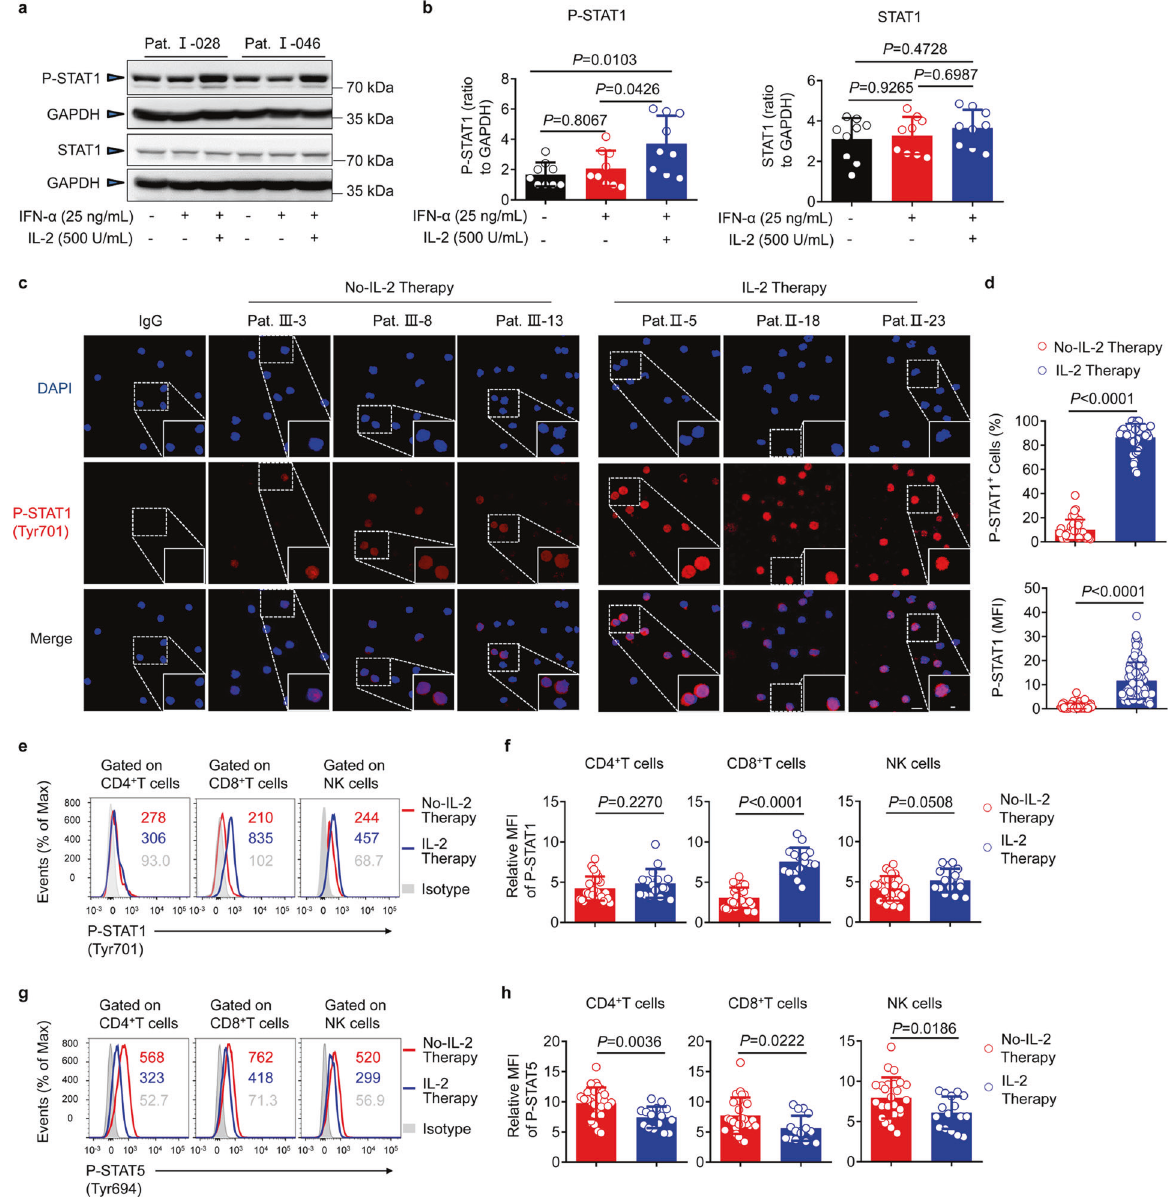
Fig. 4 Increased P-STAT1 and decreased P-STAT5 expression after sequential IL-2 therapy in vivo. a Western blotting analysis of P-STAT1 and STAT1 levels in PBMCs of NR ( α -2b) patient at week 72 (72 w; 48 weeks of Peg-IFN- α -2b therapy and 24 weeks of follow-up). PBMCs were stimulated with IFN- α (25 ng/mL) or co-stimulated with IL-2 (500 U/mL) for 30 min ex vivo. b Graphs on the right show the densitometric evaluation of a , con fi rming their signi fi cance; n = 9. c Confocal microscopy of P-STAT1 expression in the PBMCs of patients, with or without sequential IL-2 therapy for 24 weeks. d (Upper) Statistics were based on the percentage of P-STAT1 + PBMCs per fi eld of each group; each dot represents the percentage of P-STAT1 + PBMCs in one fi eld. The total number of fi elds counted in each group without (No-IL-2) and with sequential IL-2 therapy was 36 and 37, respectively. (Lower) Statistics were based on the MFI of P-STAT1 from randomly selected single cell from each group; the total number of P-STAT1 + PBMCs in each group without (No-IL-2) and with sequential IL-2 therapy was 64 and 113, respectively. Each dot represents the MFI of P-STAT1 in one cell. e , f Representative histograms ( e ) and relative MFI ( f ) of P-STAT1 expression in gated CD4 + T cells (left), CD8 + T cells (middle), and NK cells (right) within the PBMCs of NR ( α -2b) patients, without (red, n = 26) or with (blue, n = 16) sequential IL-2 treatment for 24 weeks. g , h Representative histograms ( g ) and relative MFI ( h ) of P-STAT5 expression in gated CD4 + T cells (left), CD8 + T cells (middle), and NK cells (right) within the PBMCs of NR ( α -2b) patients, without (red, n = 26) or with (blue, n = 16) sequential IL-2 treatment for 24 weeks. Data are analyzed by one-way ANOVA with Tukey ’ s multiple comparisons test ( b ), or two tailed unpaired Student ’ s t test ( d , f , h ); * P < 0.05; ** P < 0.01; *** P < 0.001; **** P < 0.0001. Data are presented as mean ±